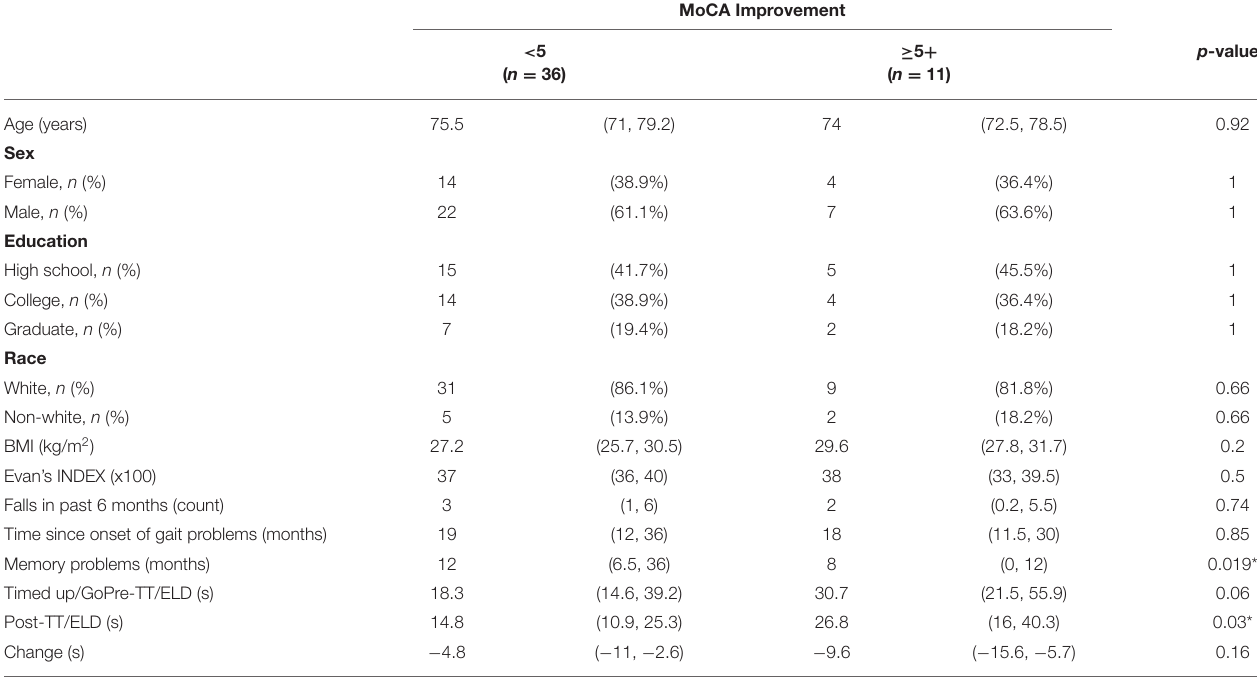
scatter plot of baseline MoCA scores by changes in MoCA from baseline to post-TT/ELD. Table 2 shows percent of patients considered having a reliable change after the TT/ELD for patients who did and did not receive a shunt. The values were roughly similar across those groups. The percent of patients with a reliable change of 5 or more points for those who got a shunt ranged from 23 to 28% depending on the method